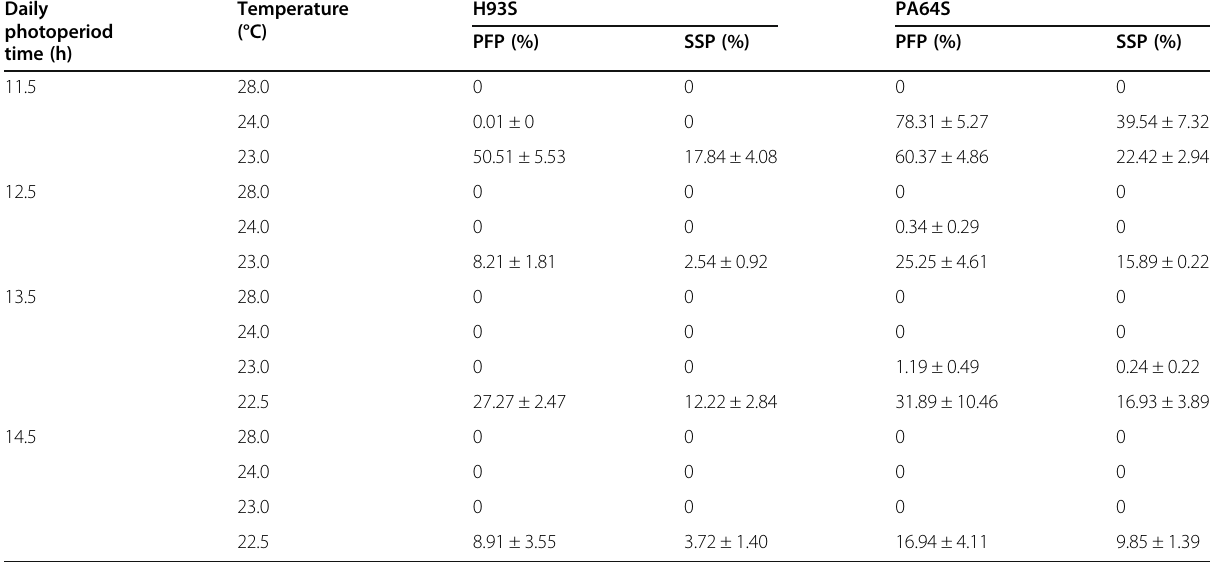
Table 1 Fertility results in response to light-temperature combinations for the CSITs of H93S and PA64S Daily photoperiod time